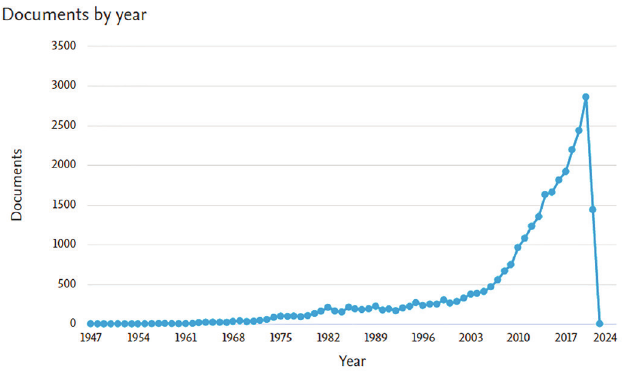
Figure 1 - Number of published articles by